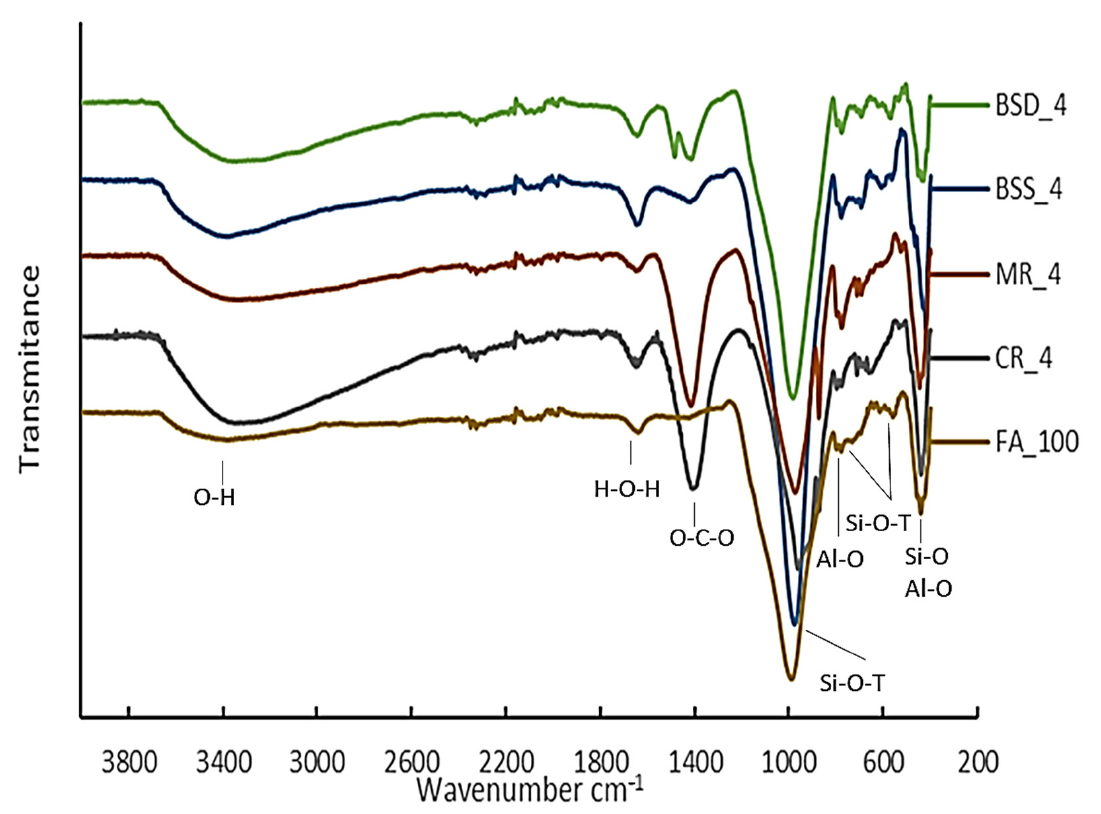
Figure 5. Infrared transmission spectra of the geopolymers produced from waste materials: BSD_4 (100 wt.% brick sanding dust), BSS_4 (100 wt.% processed brick scrap), MR_4 (100 wt.% mixed rubble), CR_4 (100 wt.% concrete rubble), and FA_100 (100 wt.% fly ash).